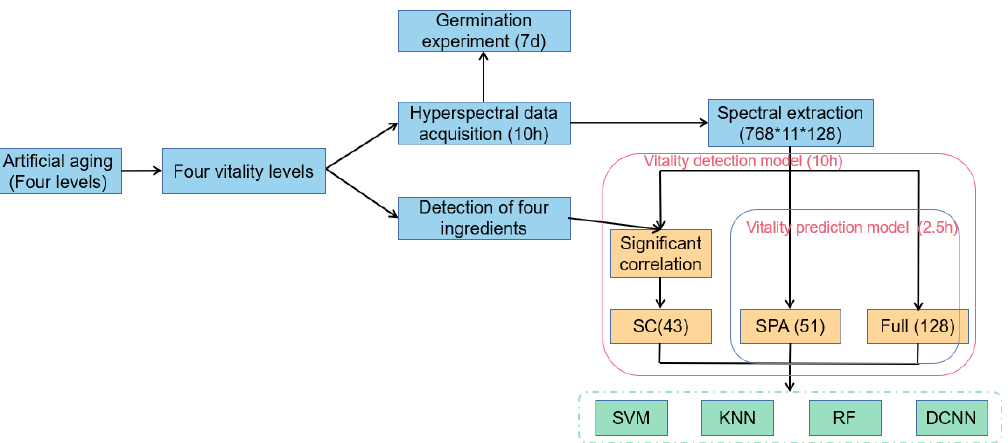
Figure 1. Flow chart for detecting and predicting the viability of waxy corn seeds using hyperspec- tral imaging.